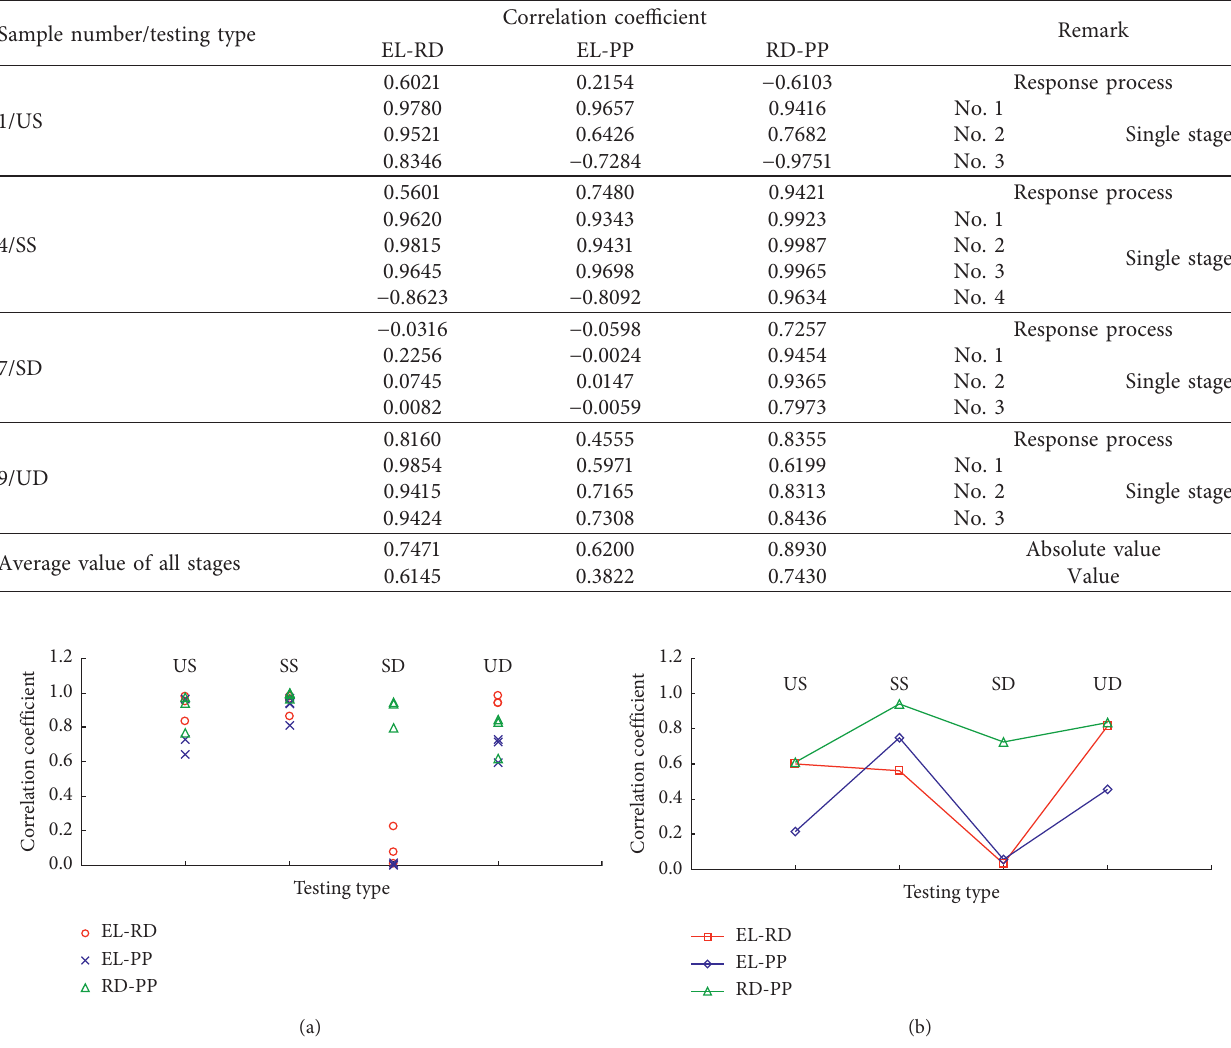
Table 5: Correlation coefficients between laboratory data of external loading (EL), residual deformation (RD), and pore pressure (PP).